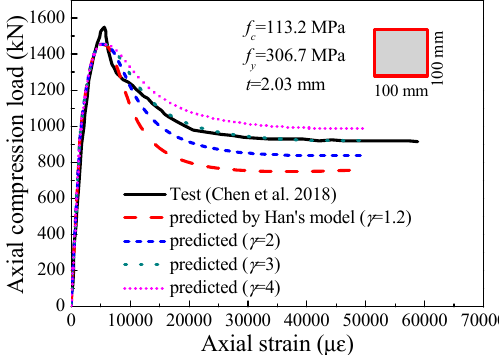
Figure 7. Full N - ε curves of specimen SS2-2 with di ff erent γ values [29].